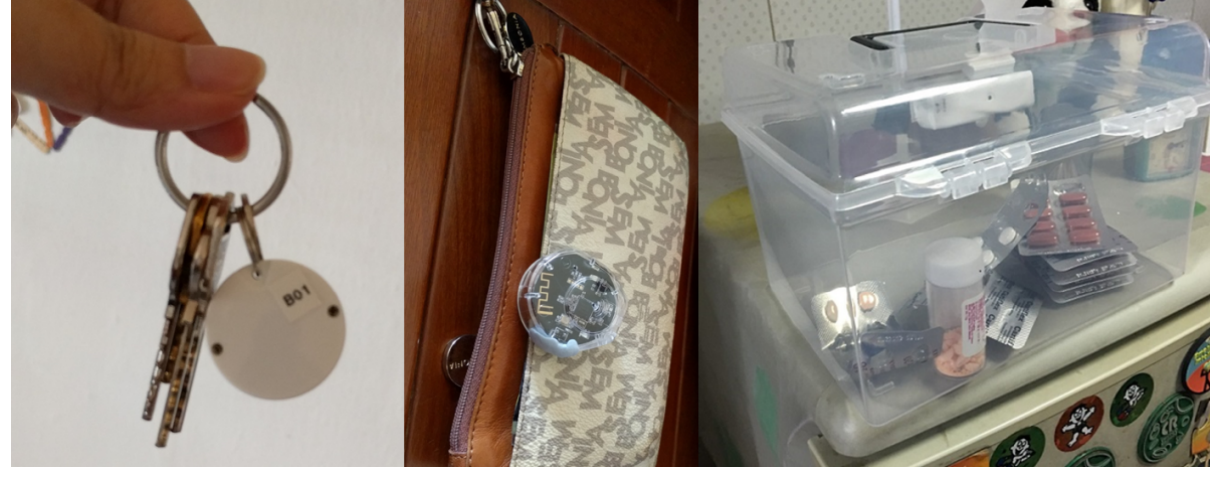
Figure 2. Proximity beacon tags to wallet and keys and sensor-equipped medication